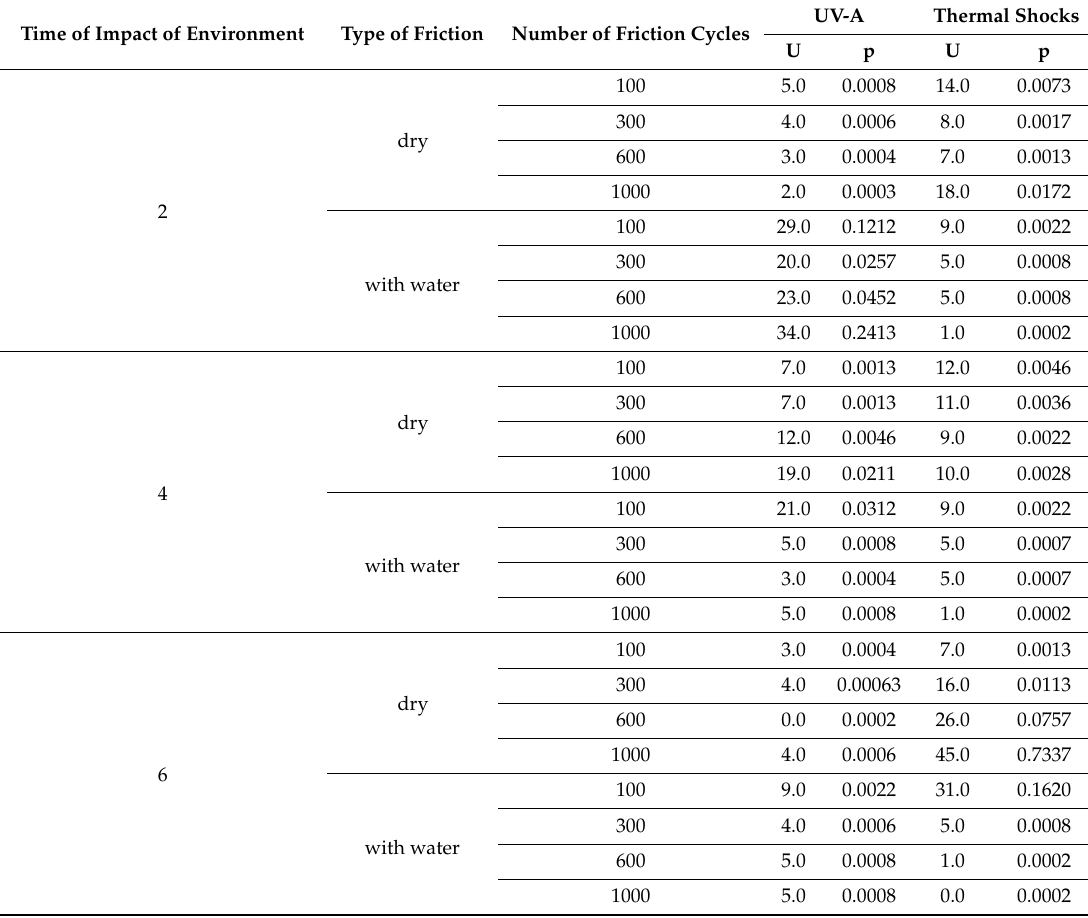
Table 4. Assessment results of the statistical significance of the impact of time of environment on the weight loss, depending on the type and number of friction cycles (the impact is significant if probability p <